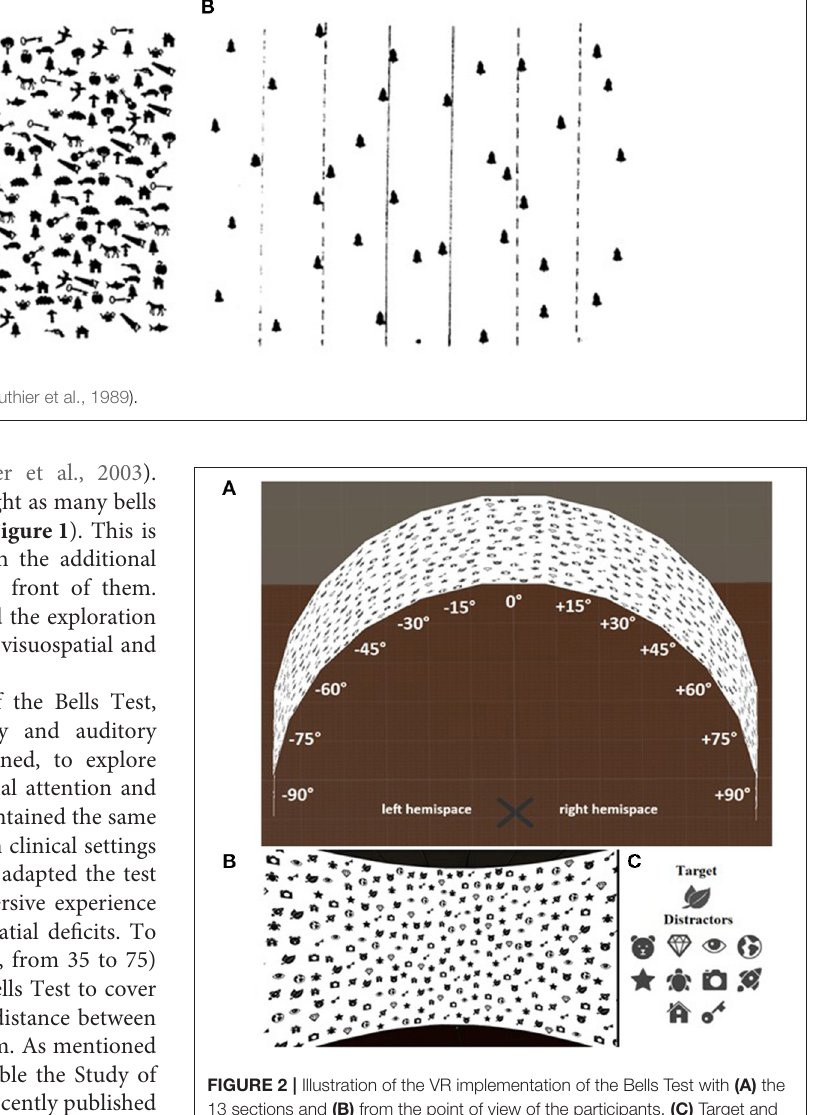
FIGURE 2 | Illustration of the VR implementation of the Bells Test with (A) the 13 sections and (B) from the point of view of the participants. (C) Target and distractor items used in the VR